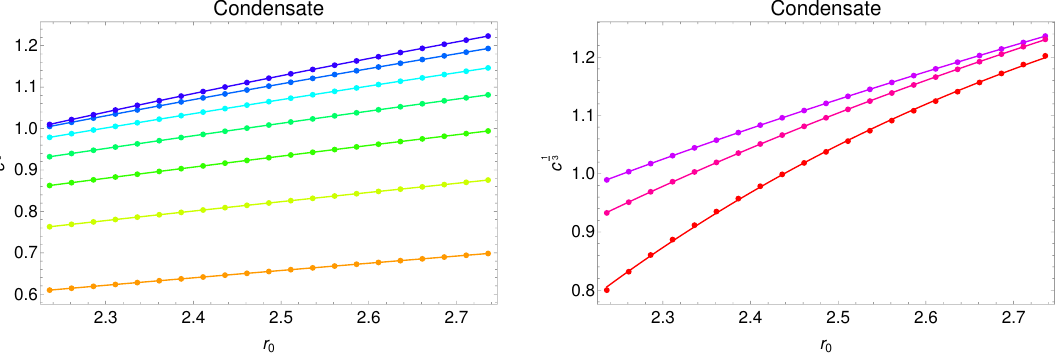
Figure 18 . Condensate of horizon ending branes.